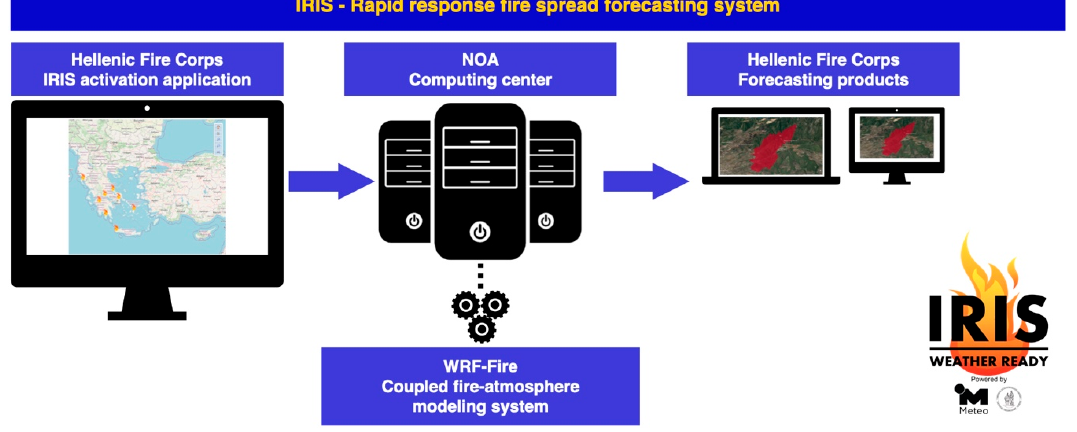
Figure 2. Flow chart of the IRIS rapid response fire spread forecasting system.